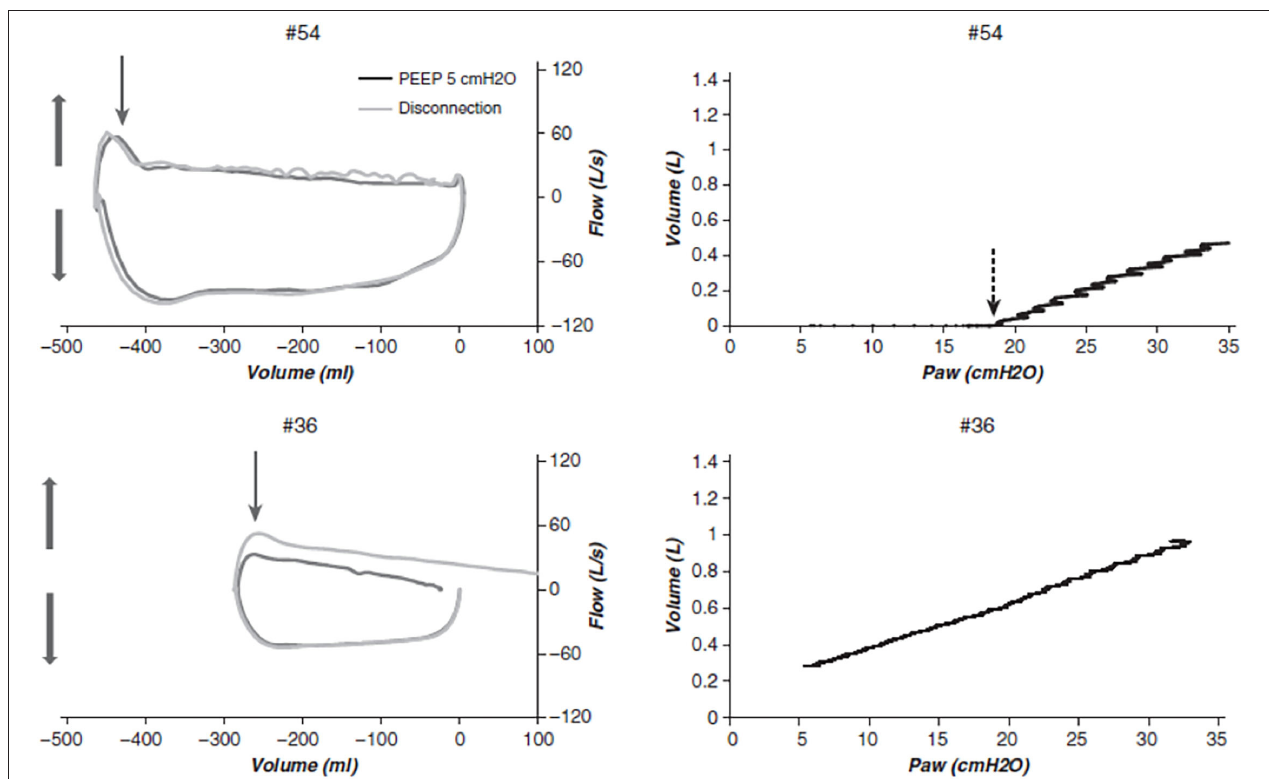
FIGURE 3 | Confrontation of flow-volume and VP relationships in two patients with acute respiratory distress syndrome (ARDS). Flow–volume and pressure–volume (PV) curves from two representative patients (#54 and #36) in the present study. Left : flow–volume loops during baseline mechanical ventilation and after disconnecting (thin arrows) to the atmosphere. Upper : A patient with expiratory flow limitation (EFL) over the whole expiratory volume, meaning that the whole breath happens in the closing volume. Lower : A patient without EFL. Thick vertical arrows indicate expiration (upward) and inspiration (downward) directions. The expiratory time constant was measured during disconnection as the time required to exhale 63% of the insufflated volume. Right : Corresponding low-flow PV curves. Upper: An early increase in pressure does not result in an increase in volume up to a point (vertical dashed arrow), at which the volume suddenly increases. This pattern is consistent with airway reopening in this patient with EFL. The airway opening pressure was determined by visual inspection, and the compliance of the PV curve from PEEP with the Paw was computed. Lower : A sustained increase in volume from the onset of pressurization indicates the absence of a critical airway opening pressure in this patient without EFL. Paw, airway pressure; PEEP, positive end-expiratory pressure. Reprinted with permission of the American Thoracic Society. Copyright © 2021 American Thoracic Society. All rights reserved. Cite: Yonis, Mortaza, Baboi, Mercat, Guérin/2018/Expiratory Flow Assessment in patients with ARDS. A reappraisal/AJRCCM/198/Pages 131-134. The American Journal of Respiratory and Critical Care Medicine is an official journal of the American Thoracic